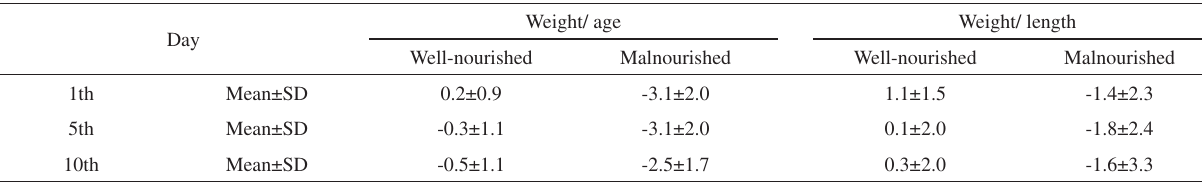
Table 3 - Z score for weight/age and weight/length in malnourished and well-nourished patients on the first, fifth and tenth